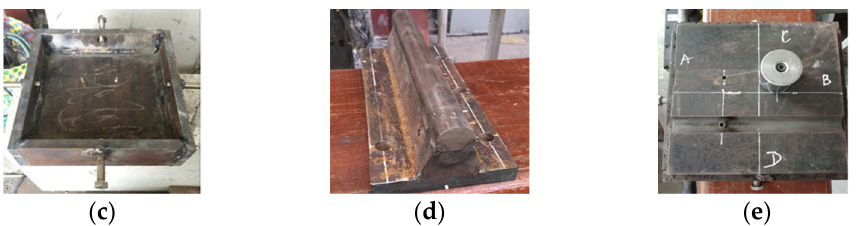
Figure 6. Setup of typical compression test: ( a ) Uniaxial loading; ( b ) Biaxial loading; ( c ) Adapter plate for uniaxial loading; ( d ) Ball joint for uniaxial loading; ( e ) Adapter plate and ball joint for biaxial loading.